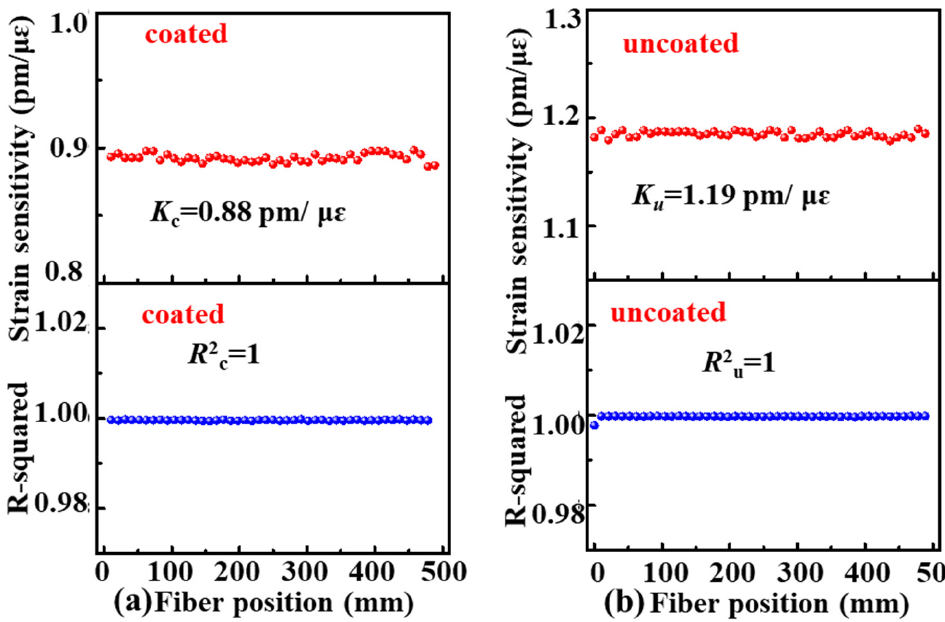
Figure 4. The calculated strain sensitivity and the R-Squared at each position from 0 to 500 mm along the axes of the ( a ) coated and ( b ) uncoated SMF samples.